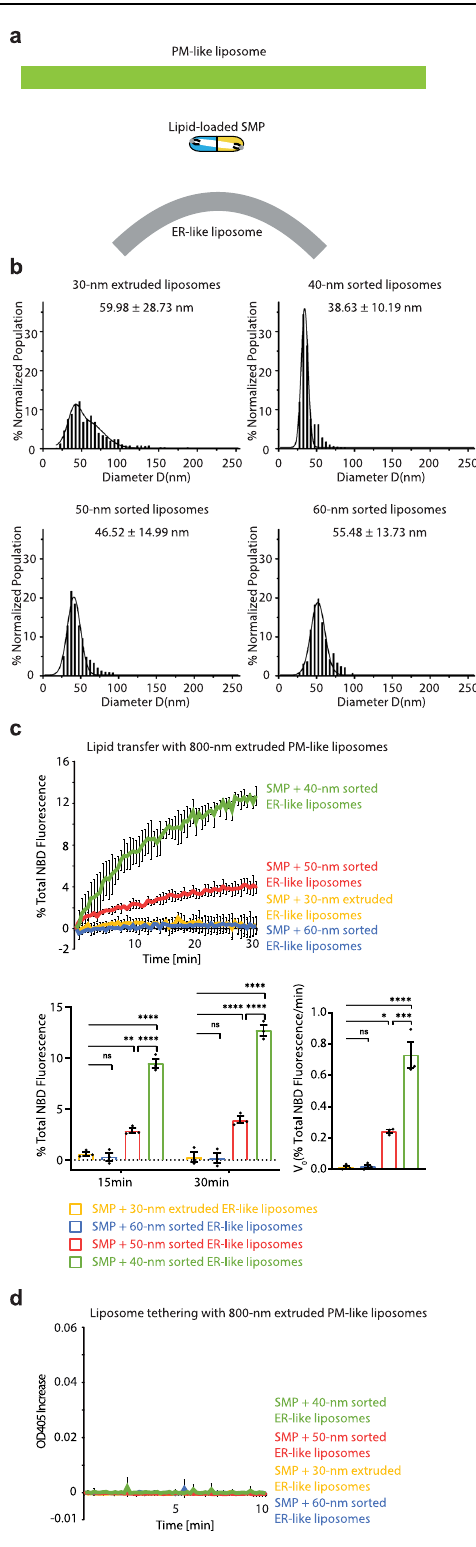
Fig. 2 | Extreme membrane curvature is essential for SMP-mediated lipid transfer. a , Schematic representation of SMP-mediated lipid transfer between curved ER-like and fl at PM-like liposomes. b , Size distributions of distinctly sized ER-likedonorliposomesprepared fromextrusion through fi lterswith30nmpores followed by DNA-brick-assisted sorting or not. Diameters of liposomes were mea- sured from negative-staining TEM images. Average diameters are presented as mean±SD ( n =548, 1959, 916, and 329 liposomes from left to right). c , Top, time courses of lipid transfer between distinctly sized ER-like donor liposomes and PM- likeacceptorliposomesinthepresenceofSMPat37°Casassessedbydequenching of NBD-PE fl uorescence. Bottom left, quanti fi cations of NBD fl uorescence after incubation for 15min or 30min. Bottom right, initial transfer rates. Data are pre- sentedasmean±SD( n =3independentexperiments).ns,notsigni fi cant;*P<0.05, ** P <0.01, **** P <0.0001 by two-way ANOVA with Bonferroni ’ s multiple compar- isons test (bottom left) or by one-way ANOVA with Bonferroni ’ s multiple compar- isons test (bottom right). P values: 6.4 × 10 − 3 (bottom left, 15min), 5.3 × 10 − 5 (bottomleft,30min),and0.030(bottomright)for[(SMP+30-nmextrudedER-like liposomes) vs (SMP+50-nm sorted ER-like liposomes)]; 2.6 × 10 − 10 (bottom left, 15min),1.5×10 − 12 (bottomleft,30min),and1.3×10 − 5 (bottomright)for[(SMP+30- nm extruded ER-like liposomes) vs (SMP+40-nm sorted ER-like liposomes)]; 2.0 × 10 − 8 (bottom left, 15min), 3.0 × 10 − 10 (bottom left, 30min), and 2.3 × 10 − 4 (bottomright)for[(SMP+50-nmsortedER-likeliposomes)vs(SMP+40-nmsorted ER-like liposomes)]. d , Time courses of the tethering of distinctly sized ER-like donorliposomesandPM-likeacceptorliposomesinthepresenceofSMPat37°Cas assessed by an increase in turbidity (OD at 405nm). Data are presented as mean±SD ( n =3 independent experiments). Source data are provided as a Source Data fi